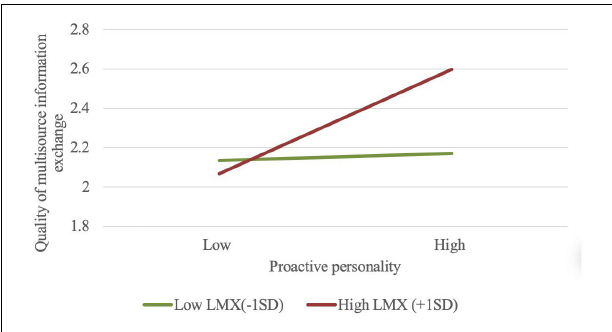
FIGURE 2 | Interaction plot of proactive personality and LMX on the quality of multisource information exchange.